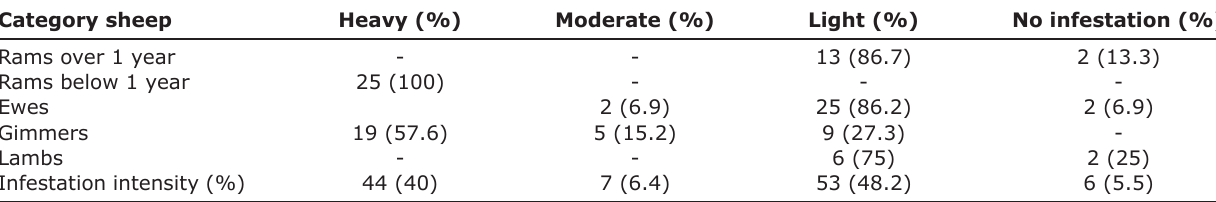
Table-4: Intensity of gastrointestinal nematodes infestation of sheep in Ayeduase. Category sheep